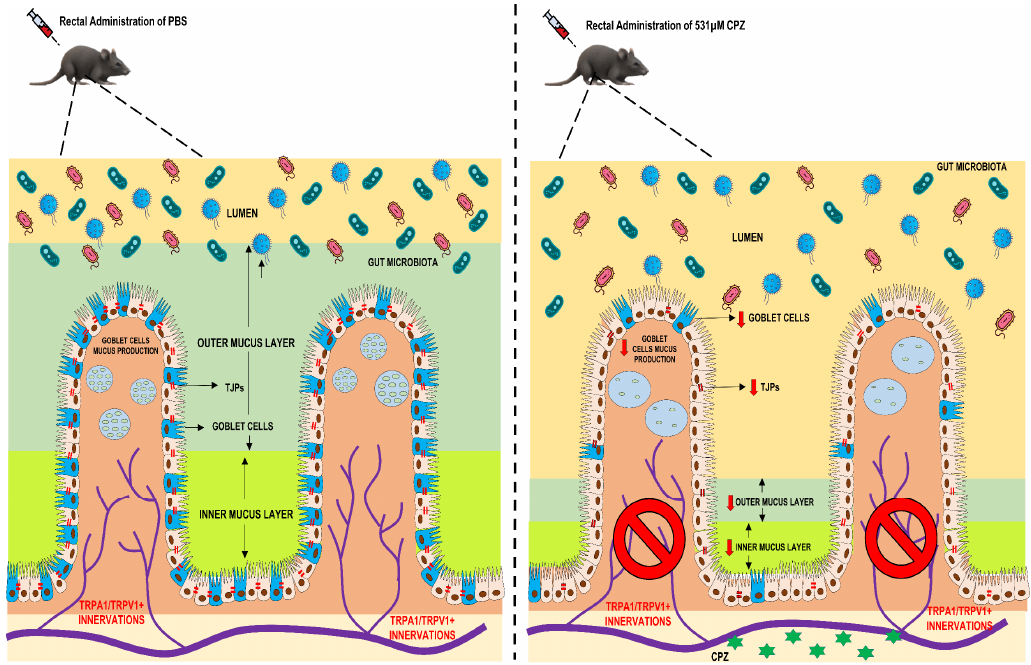
Figure 6. Representative image for overall effects of CPZ ‐ induced alterations in colonic mucus production and gut health.